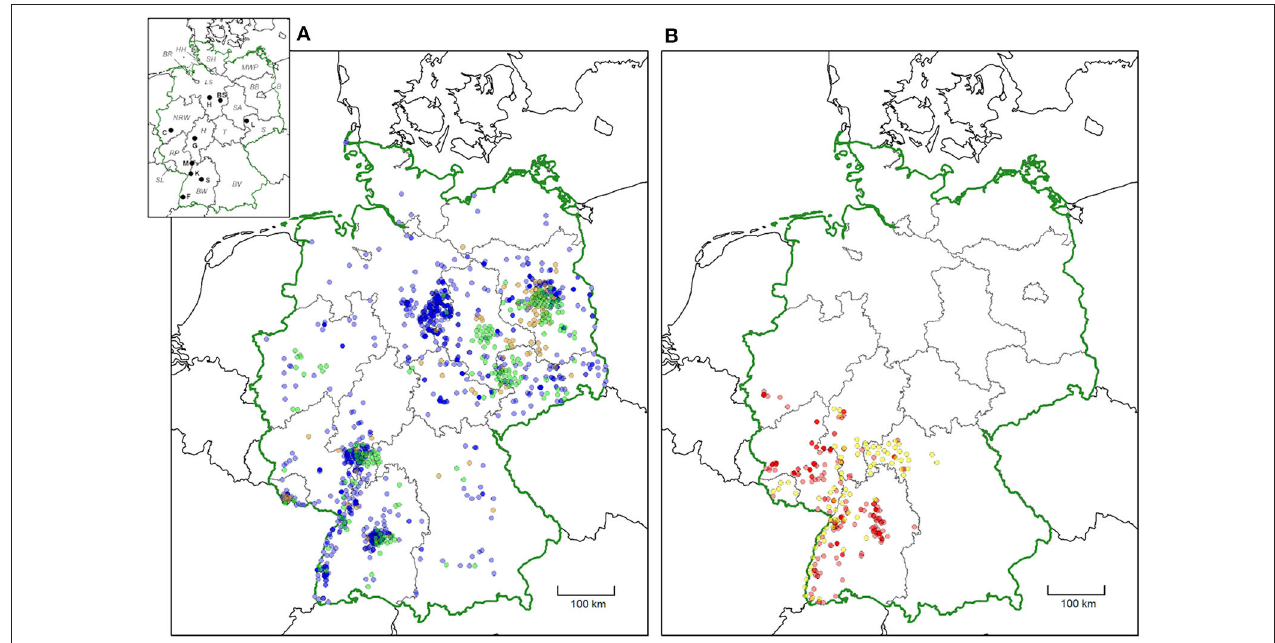
FIGURE 2 | Distribution of (A) Dermacentor reticulatus (blue dots) and (B) Dermacentor marginatus (red dots) in Germany based on ticks submitted by German citizens from February 2019 to February 2020 in comparison to data from previous studies. In (A) , D. reticulatus locations as reported by Rubel et al. ( 1) are shown in orange and those reported by Naucke ( 13) in green. In (B) D. marginatus locations as reported by Rubel et al. (1) are shown in yellow. More intense colors indicate multiple findings in close proximity. In the map insert, federal states are abbreviated with italic letters (B, Berlin; BR, Bremen; BW, Baden-Wuerttemberg; BV, Bavaria; BB, Brandenburg; HH, Free and Hanseatic City of Hamburg; H, Hesse; LS, Lower Saxony; MWP, Mecklenburg-Western Pomerania; NRW, North Rhine-Westphalia; RP, Rhineland-Palatinate; S, Saxony; SA, Saxony-Anhalt; SH, Schleswig-Holstein; SL, Saarland; T, Thuringia). Cities are abbreviated with bold letters (BS, Brunswick;